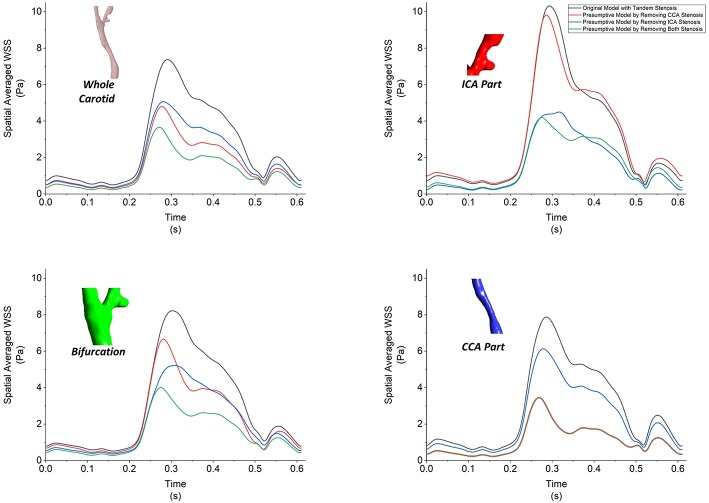
The spatial-averaged WSS at the surface of whole carotid model, local ICA part, local bifurcation part and local CCA part during one cardiac cycle for all the four models.